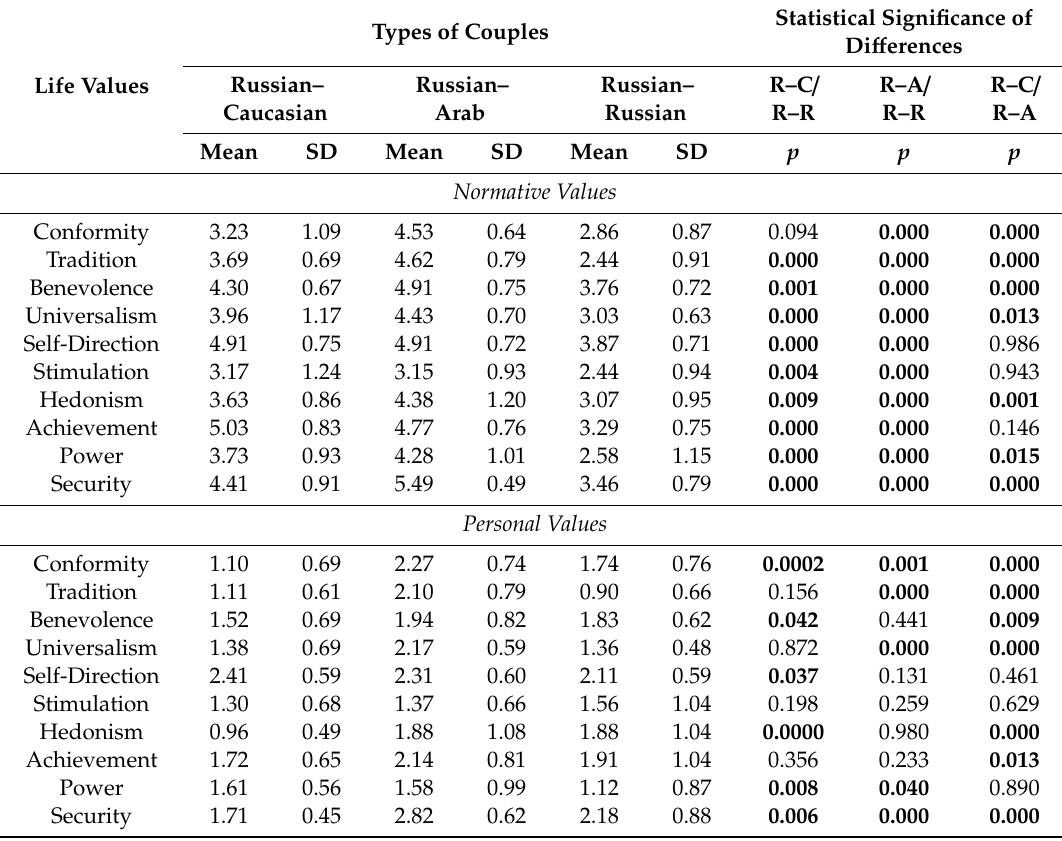
Table 1. Comparison of the importance of life values for spouses of mono-cultural, inter-ethnic and inter-faith